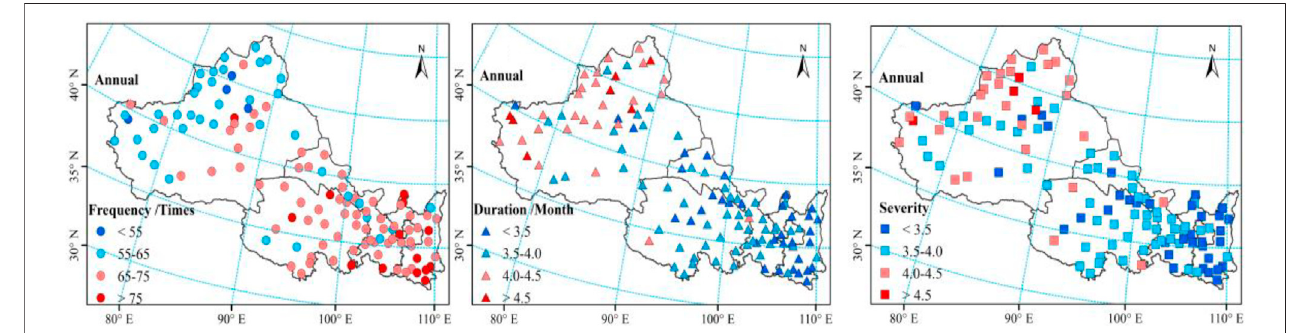
FIGURE 9 | Spatial distribution of annual drought characteristic